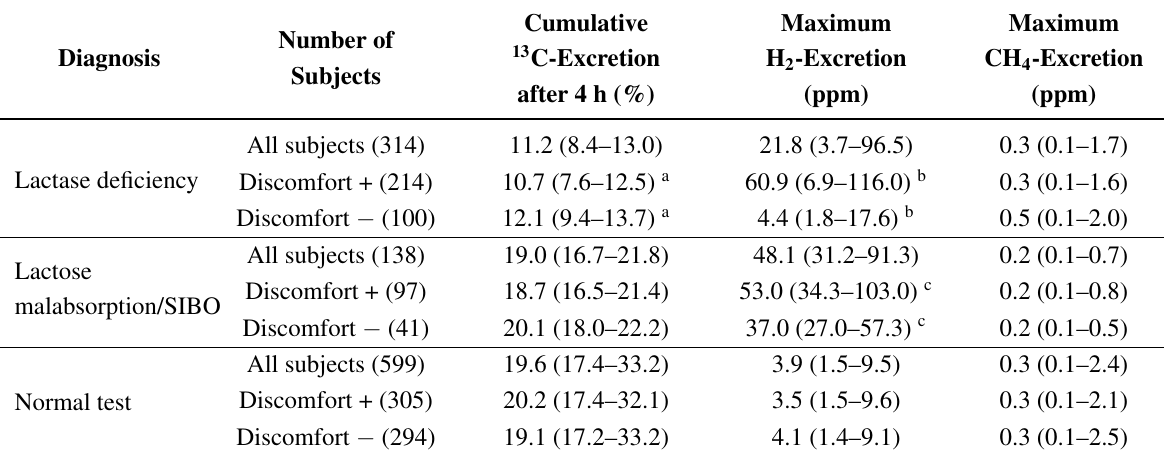
Figure 2. Percentage of subjects that reported discomfort after performing a 13 C/H 2 breath test. Table 1. 13 CO 2 , H 2 and CH 4 excretion according to diagnose.